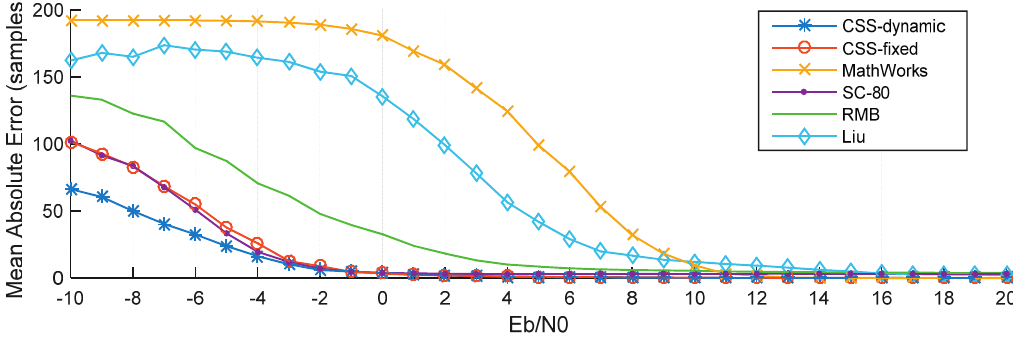
Figure 13. MAE of different methods.